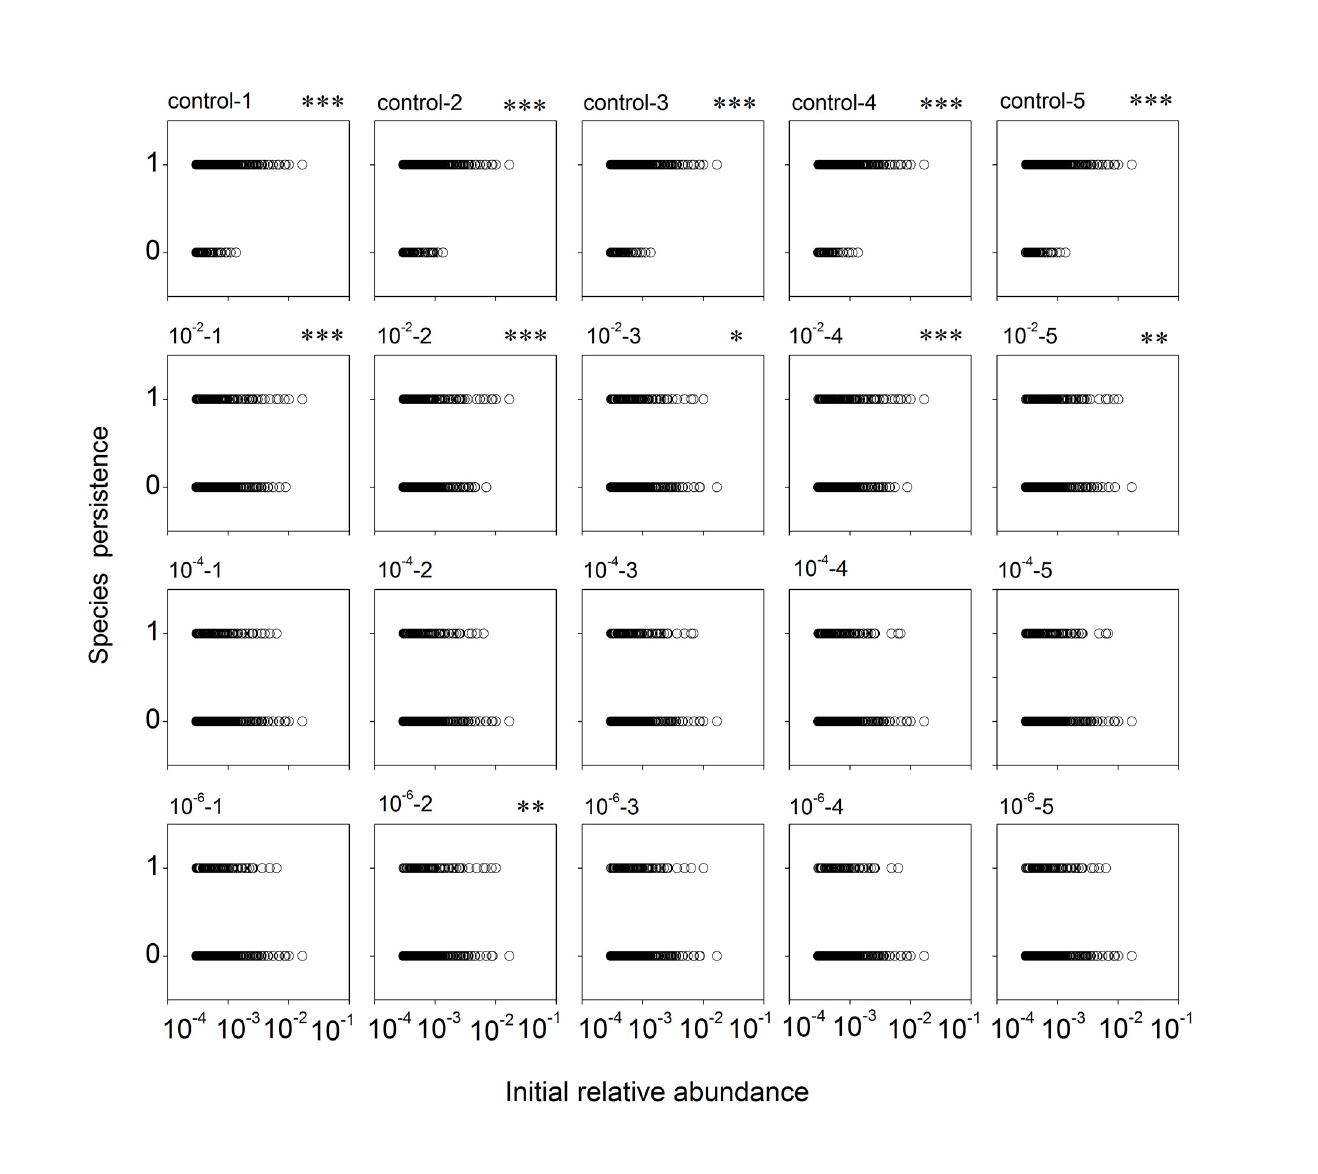
Fig 2. Persistence of species in each sandy soil microcosm as a function of initial abundances. Persistence score of 1 indicates survival, and 0 indicates extinction. Each panel is referred by its microcosm ID; e.g. ‘ control-1 ’ indicate the No. 1 microcosm under the control treatment. Asterisks indicate significantly positive abundance-persistence relationships (single asterisk, p < 0.05; double, p < 0.01; triple, p <